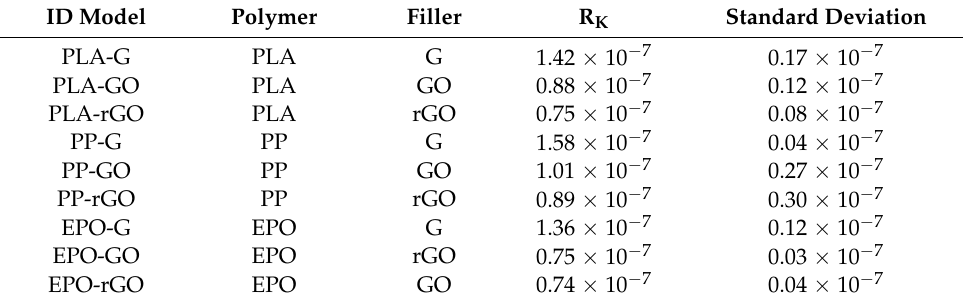
Table 3. Kapitza resistance ( R K ) of the systems studied (in m 2 K/W). ID